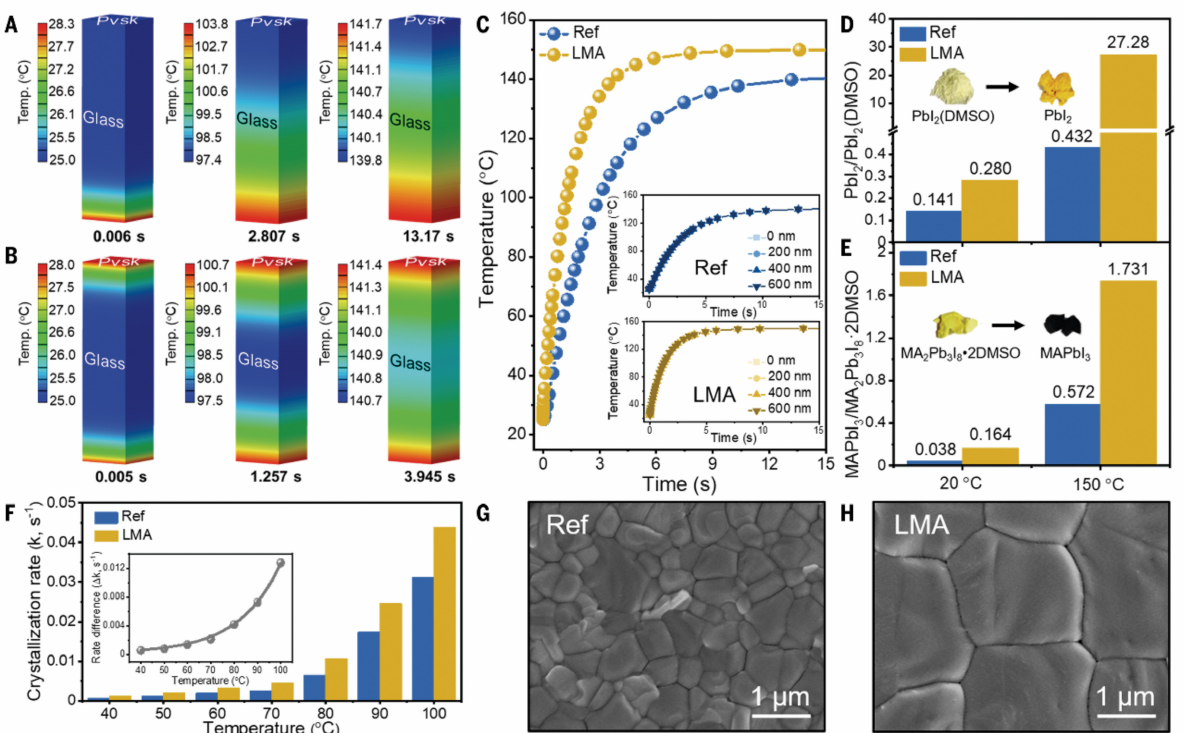
Figure 15. Finite element analysis on the thermal field distribution with annealing time with the Ref process ( A ) and the LMA process ( B ); ( C ) temperature evolution of perovskite film surface with annealing time. Inset: Temperature evolution of perovskite film at different depths; ( D ) relative content of PbI 2 /PbI 2 (DMSO) under the Ref and LMA processes at 20 ◦ C for 20 min or 150 ◦ C for 10 s, expressed as the ratio of the XRD peak areas for the PbI 2 and the PbI 2 (DMSO) signals; ( E ) relative content of MAPbI 3 /MA 2 Pb 3 I 8 · 2DMSO under Ref and LMA processes at 20 ◦ C for 20 min or 150 ◦ C for 10 s; ( F ) crystallization rate (k) of spin-coated FA 1 − x − y MA x Cs y PbI 3 − z Br z film under different temperatures (40 to 100 ◦ C) calculated from in situ ultraviolet–visible results. Inset: Crystallization rate difference (D k ) between the Ref and LMA processes (D k = k LMA − k Ref ). ( G , H ) The SEM images of films under the Ref and LMA processes. Reprinted with permission from Ref. [164].